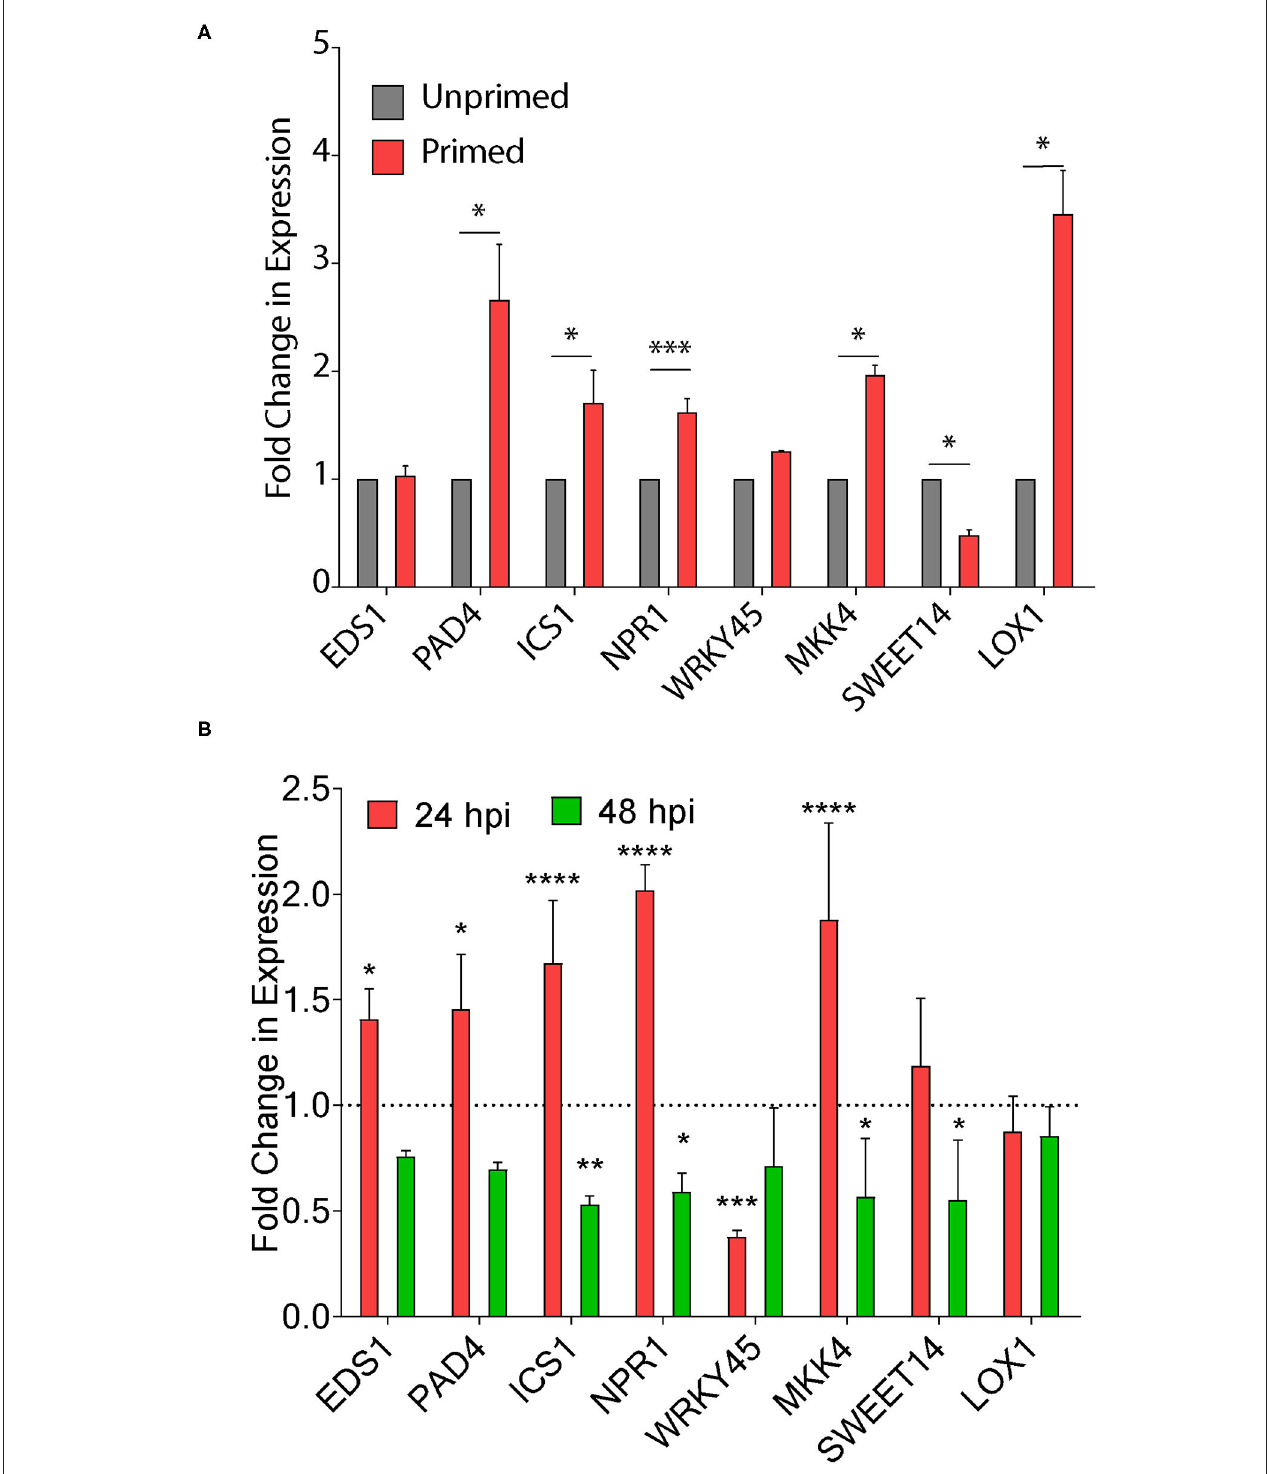
FIGURE 7 | CAGC induces plant defense responsive genes. (A, B) Change in expression of plant immunity associated genes upon seed priming (A) and Xoo infection in seed primed plants (B) . The TN1 rice seedlings were primed with C6 (50 µ g) and water-soaked seeds were used as control. The 30 days-old seed-primed plants were infected with Xoo (10 6 cfu/ml). The leaf samples were collected 24h before the infection and after 24 and 48 hpi and total RNA was isolated. The cDNA was prepared and used for qRT-PCR analysis. Values are means + SD from three biological replicates. A significant difference was determined by using two-way ANOVA with Tukey’s HSD test ( α = 0.05, * p < 0.05, ** p < 0.01, *** p < 0.001, **** p < 0.0001).